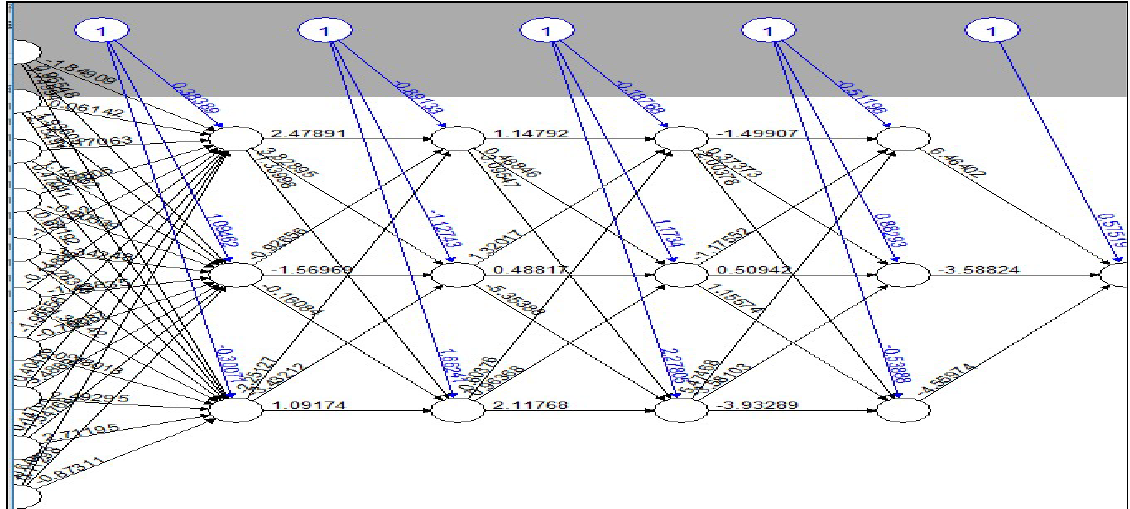
Figure 6. The structure & weights of the trained neural network